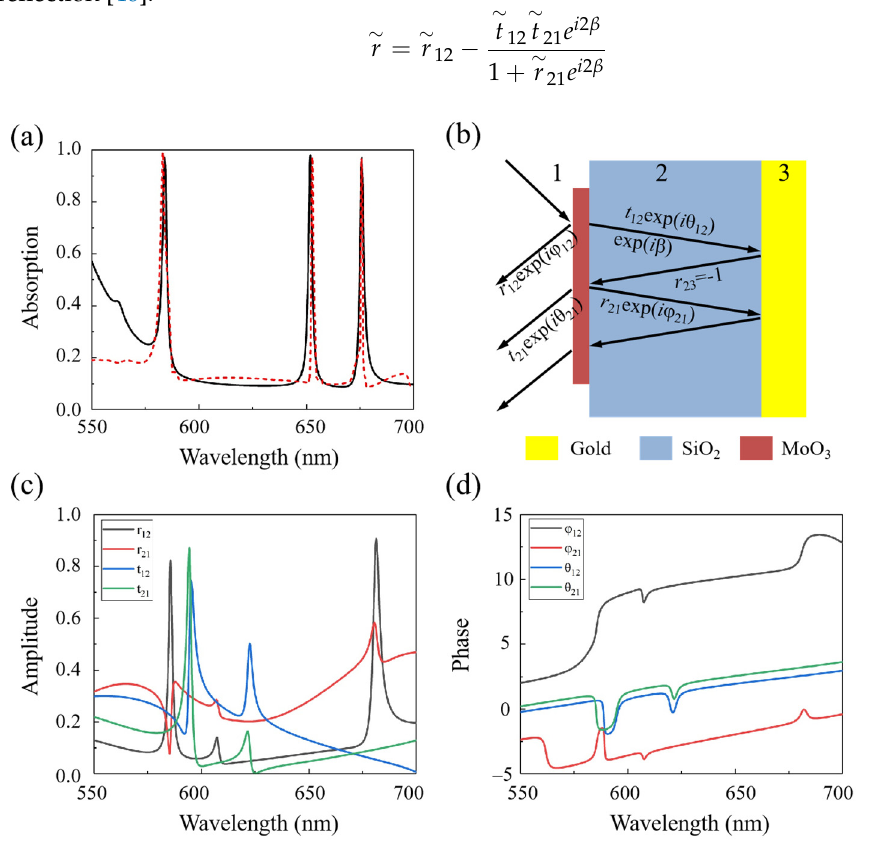
Figure 7. ( a ) The simulated absorption spectrum (black curve) of the absorber with a thickness of h = 500 nm and the calculated absorption spectrum based on the interference theory (red curve). ( b ) The interference theory model of the propose absorber. ( c ) Amplitude and ( d ) phase of the reflection and transmission coefficients obtained from proposed absorber, respectively.